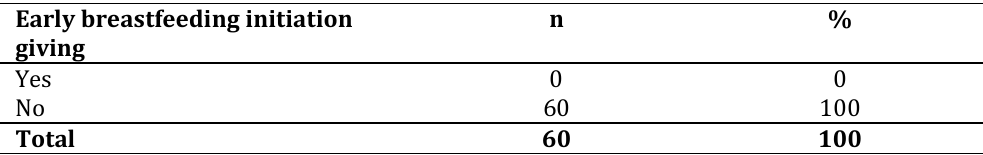
Characteristic respondent that consisted of early breastfeeding initiation giving by Post sectio Caesarea